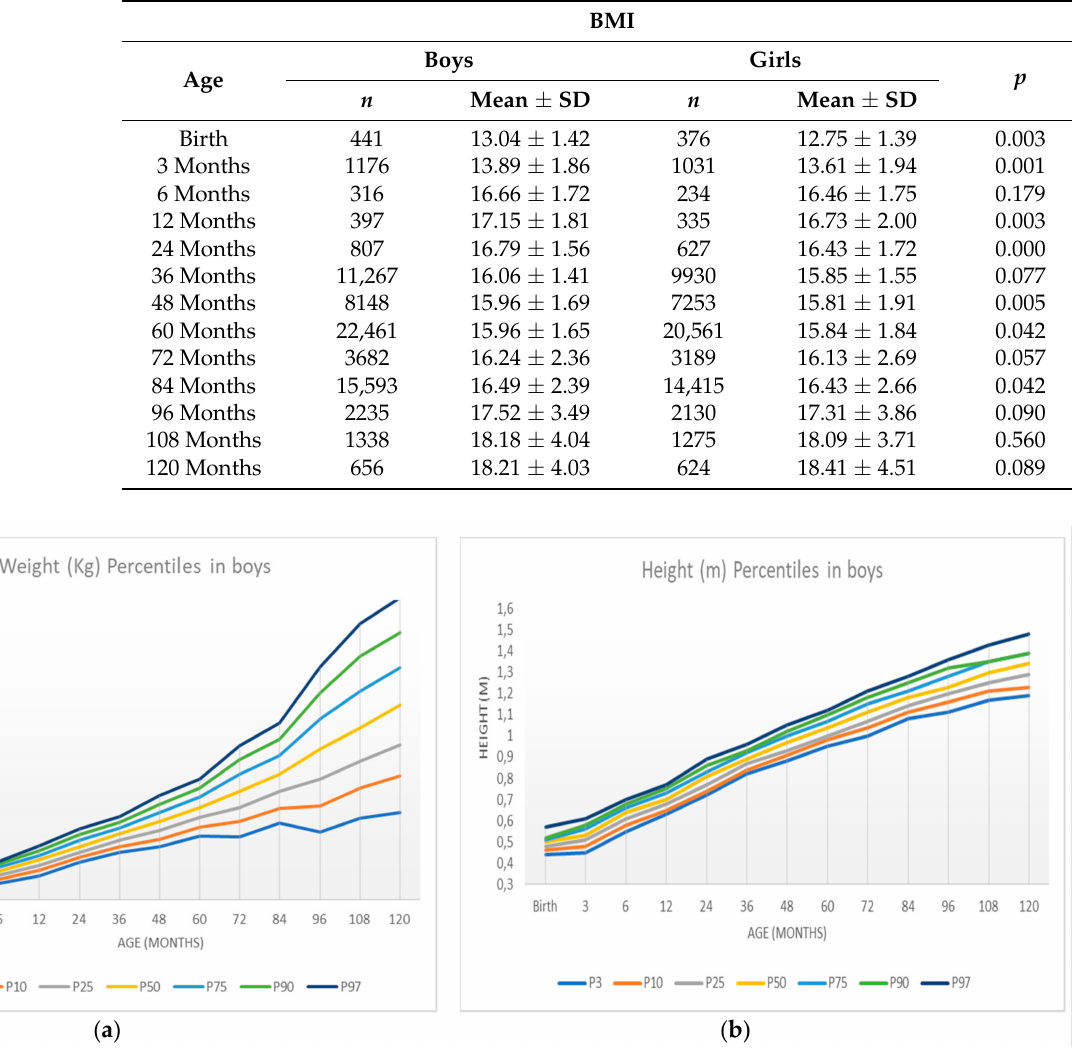
Figure 4. Weight and height percentiles in boys according to age: ( a ) weight percentiles; ( b ) height